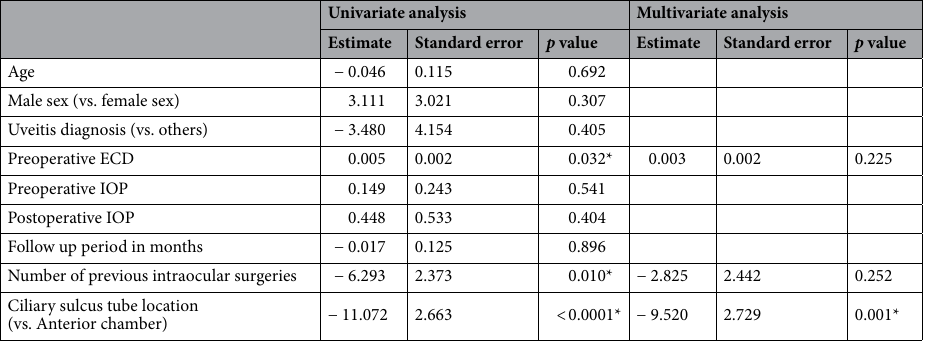
Table 5. Results of univariate and multivariate analysis of the clinical variables associated with monthly endothelial cell density loss a after Ahmed glaucoma valve implantation (N = 62 eyes, 62 patients). ECD endothelial cell density, IOP intraocular pressure. * p < 0.05. a ECD loss = Preoperative ECD – Postoperative